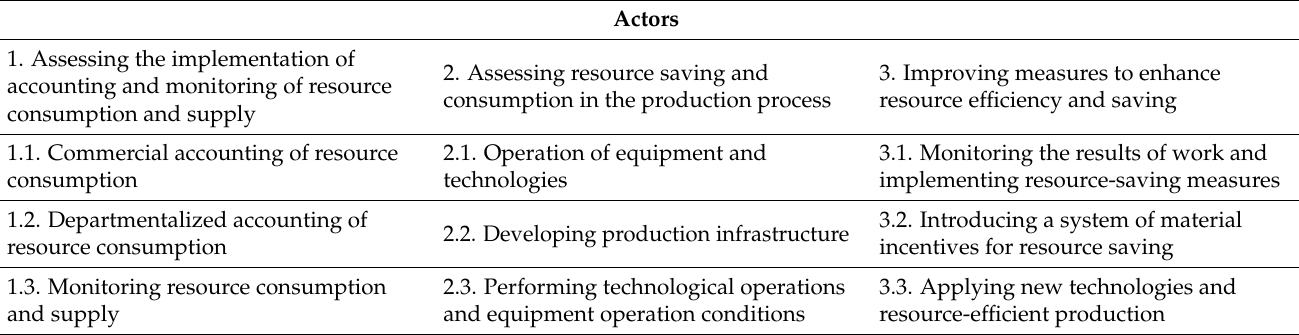
Table 1. Composition of the main and auxiliary processes at the “Actors” level. Actors